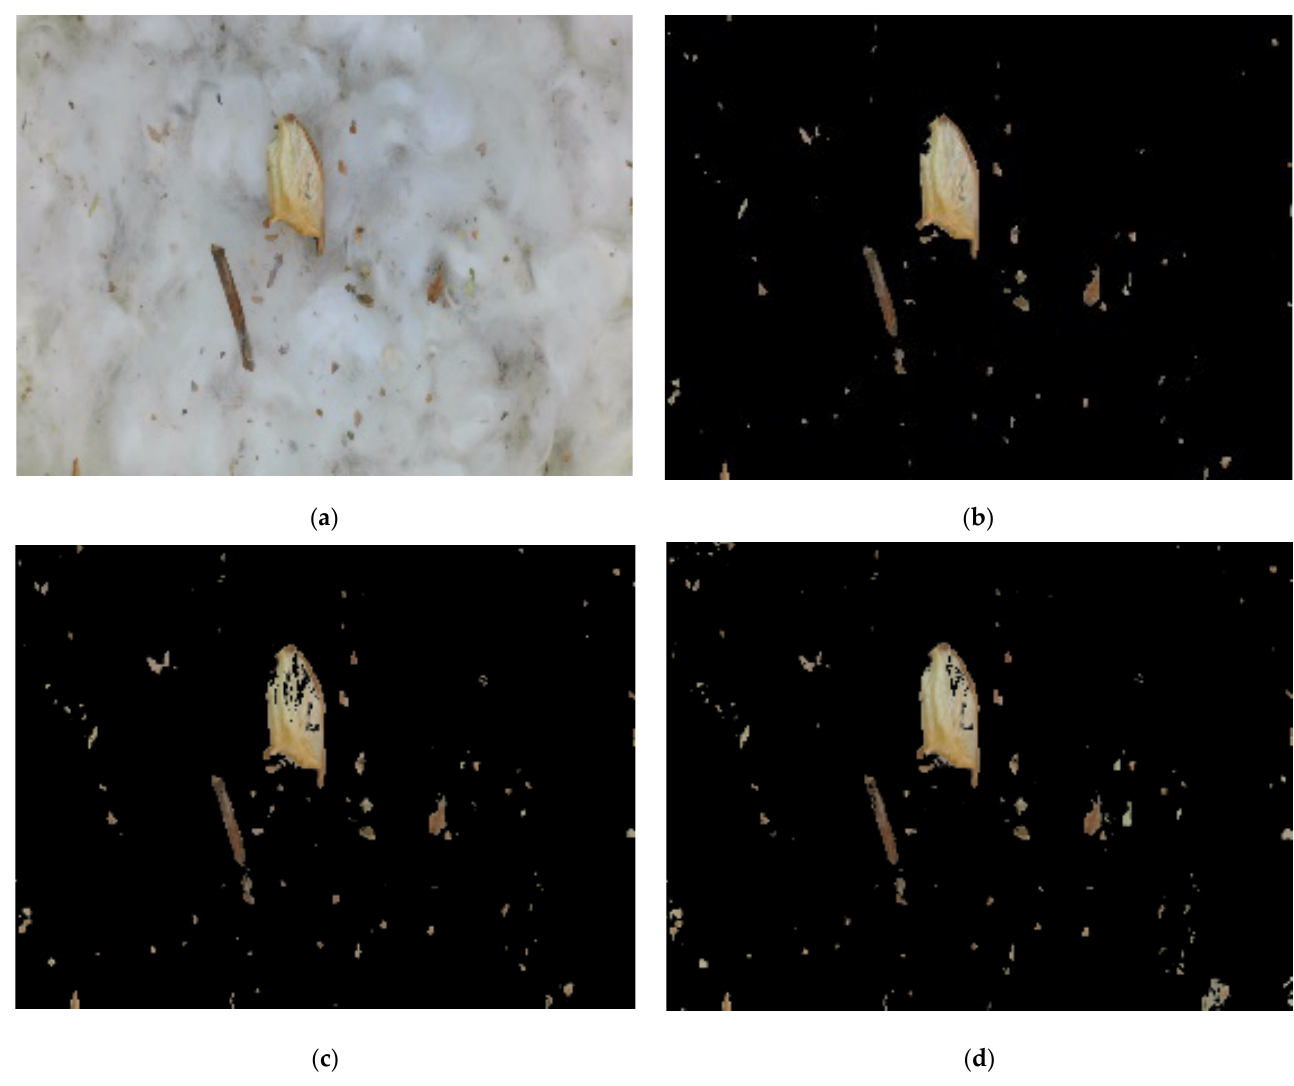
Figure 6. Original image of machine-picked seed cotton.